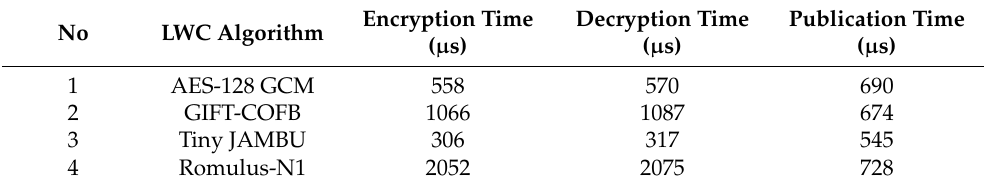
Table 3. Lightweight Cryptographic Encryption and Decryption Performance on NodeMCU with 10 Characters Messages used Anonymous Account.